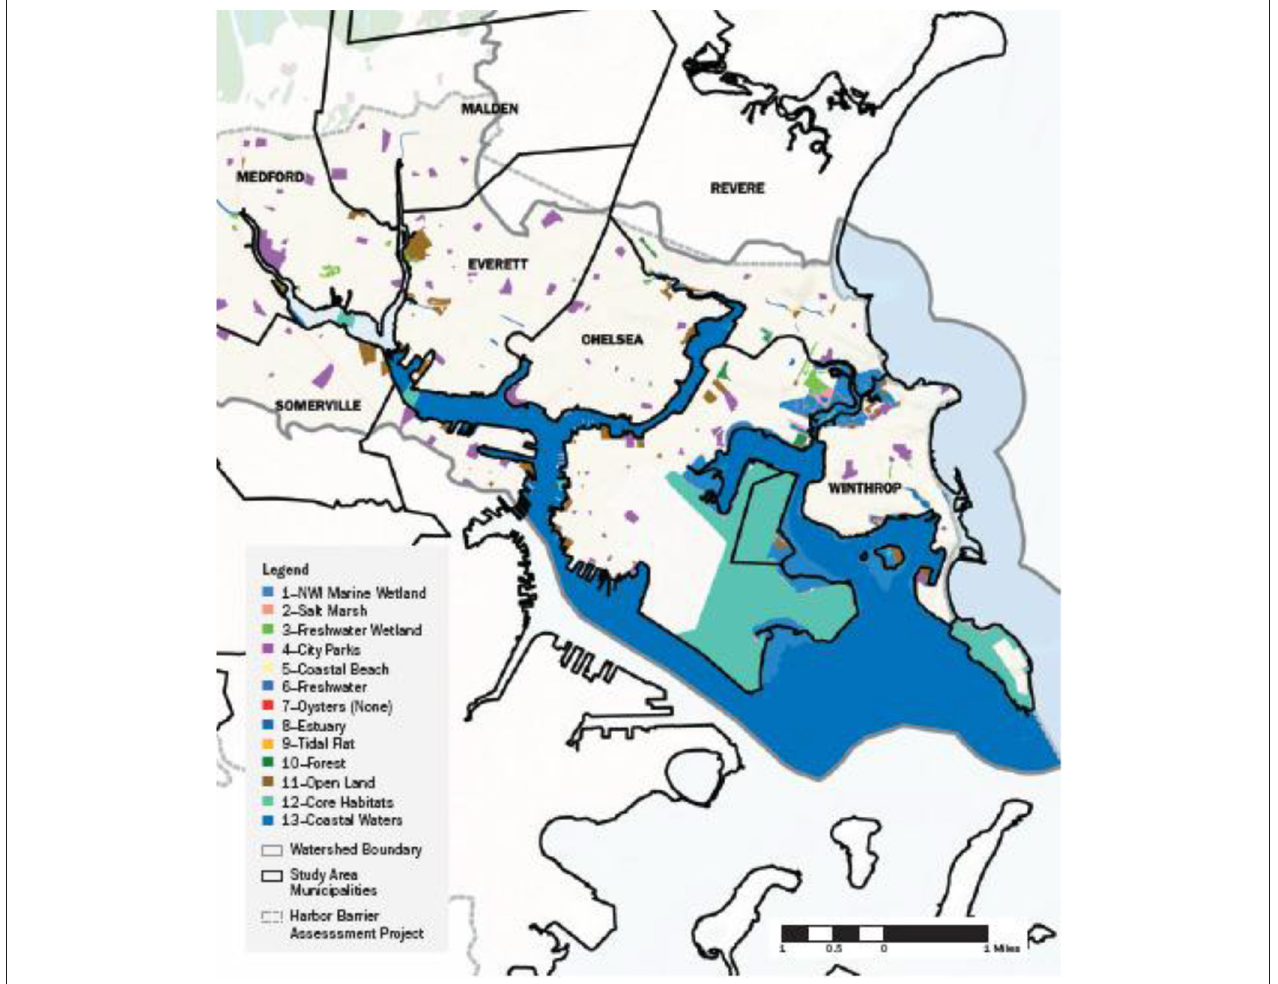
FIGURE 3 | Mystic River